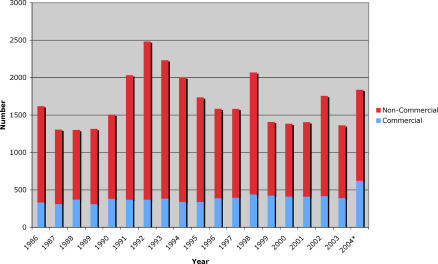
Applications to Begin Human Clinical TrialsAsterisk indicates that investigative new drug applications for therapeutic biologic products were included for the first time.